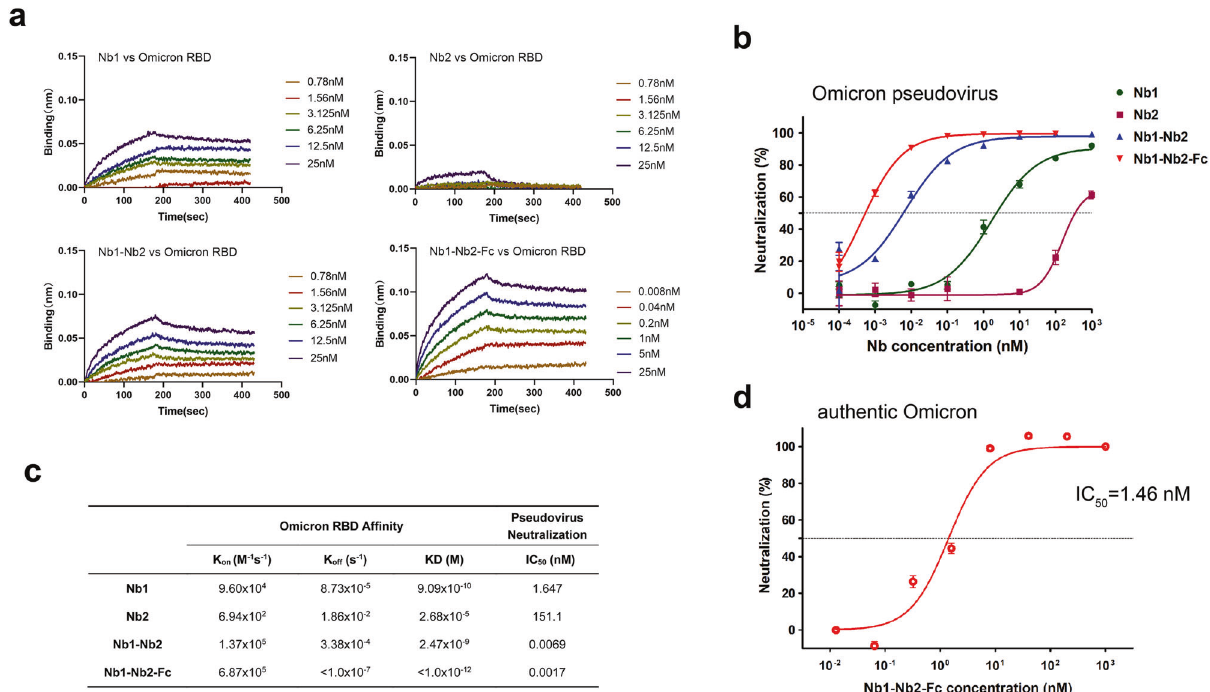
Fig. 6 Neutralization of Omicron variant (B.1.1.529). a Af fi nity analysis of four different Nbs against Omicron RBD with BLI. Fitted line plot showing the binding kinetic of four Nbs with the immobilized Omicron RBD. b Neutralization curve of Omicron pseudovirus by four